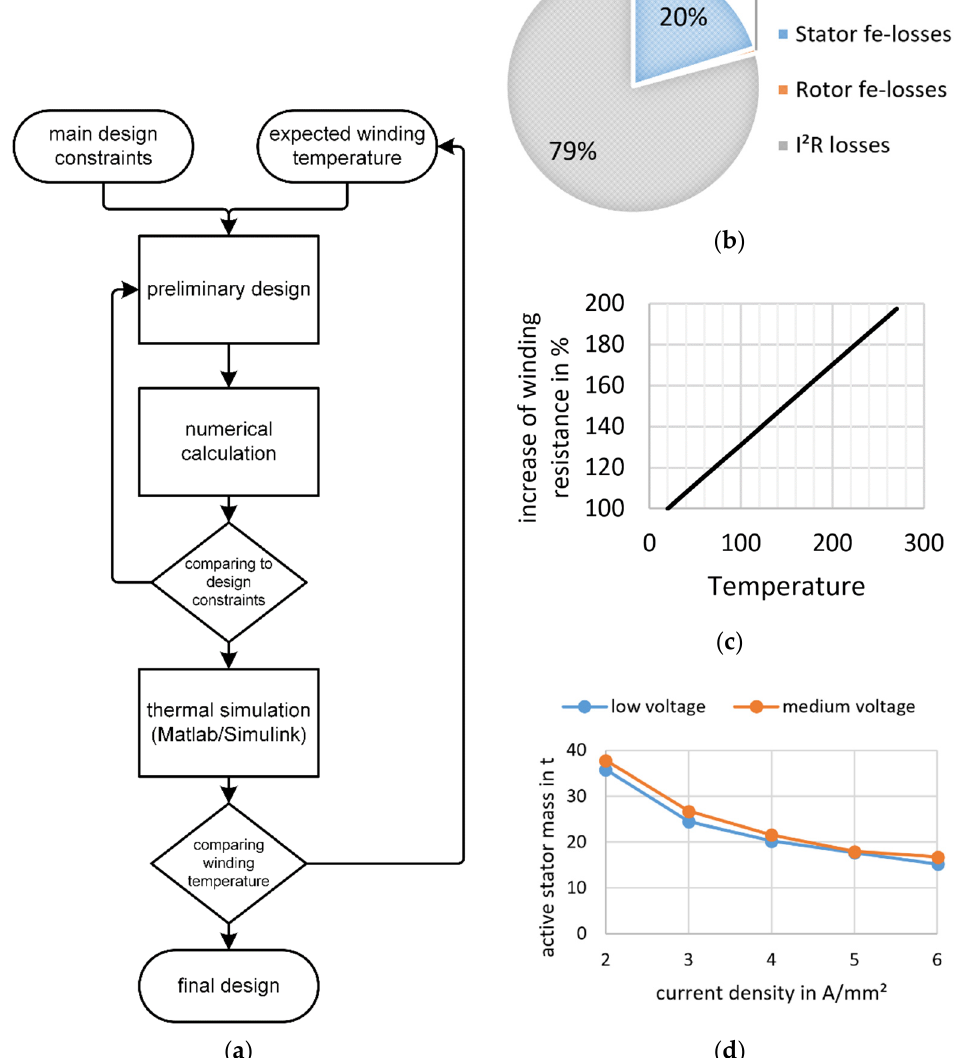
Figure 8. ( a ) Design process of the medium voltage generator; ( b ) Percentage losses in the generator; ( c ) Resistance of the winding depending on temperature; ( d ) The active mass of the stator. Table 4. Overview of the different design parameters depending on the current